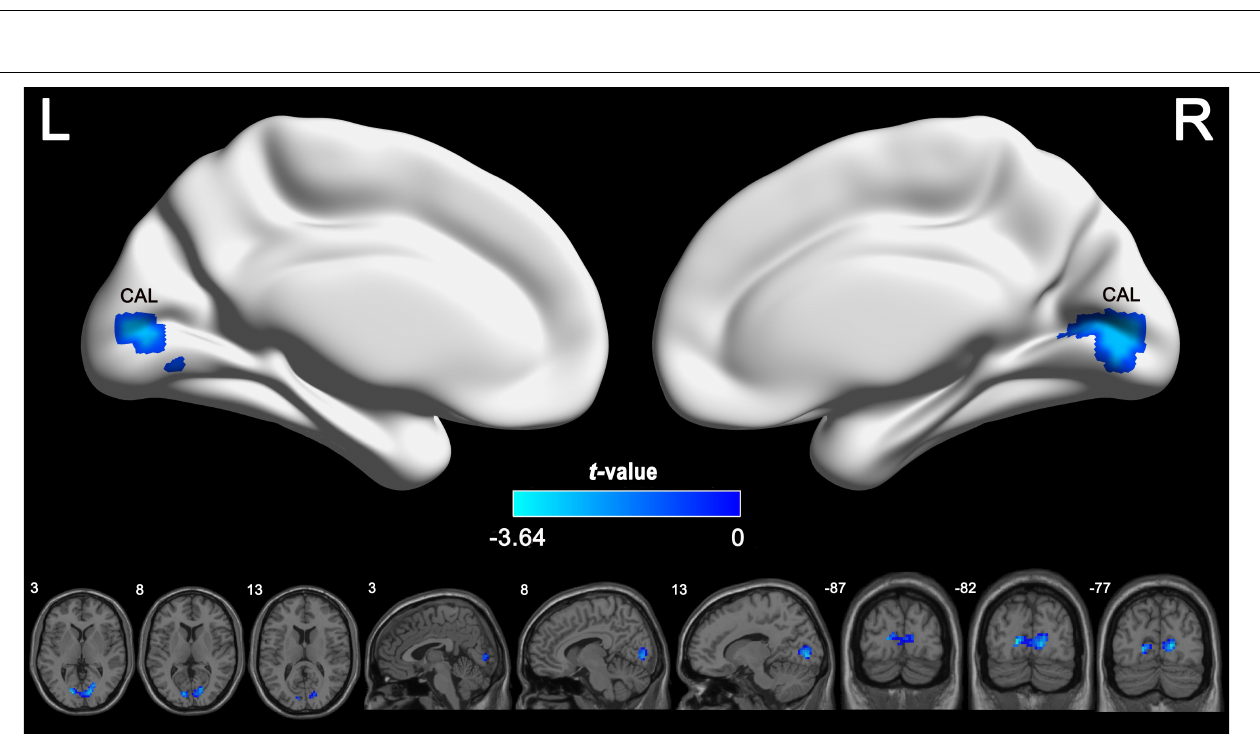
FIGURE 4 | Between-group comparisons for the seed-based functional connectivity with the seeds of right MOG. The independent two-sample t test was conducted between the IGE group and HC. All results were corrected for multiple comparisons (GRF, P < 0.05). CBF, cerebral blood flow; HC, healthy controls; GRF, Gaussian random field; IGE, idiopathic generalized epilepsy; MOG, middle occipital gyrus.